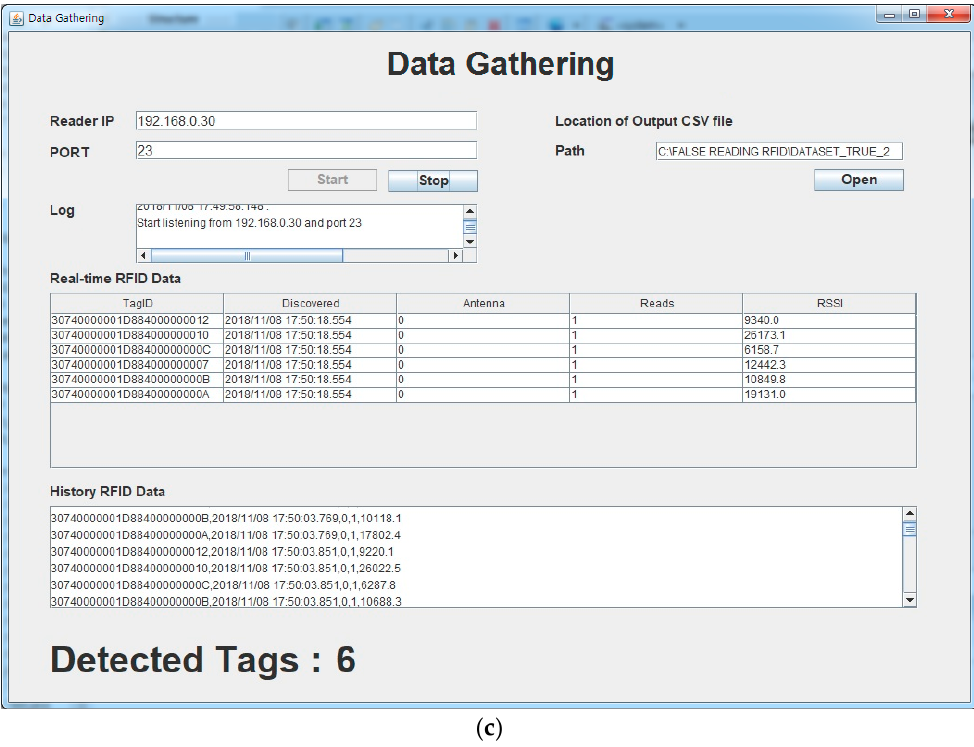
Figure 2. Data gathering: ( a ) Possible tag movements and static tag locations, ( b ) example tag movement through the gate, and ( c ) data gathering program to record tag RSS, etc.